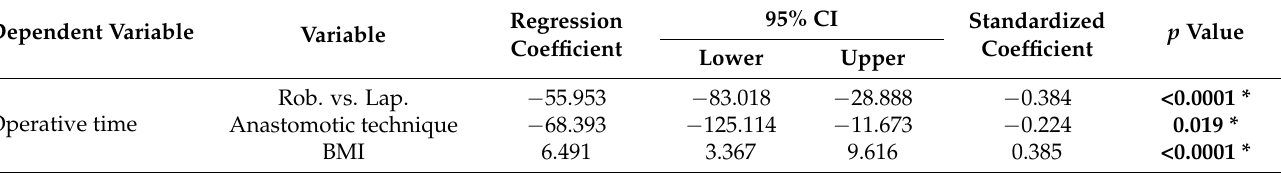
Table 5. Multiple Linear Regression Analysis of Potential Risk Factors for Operative